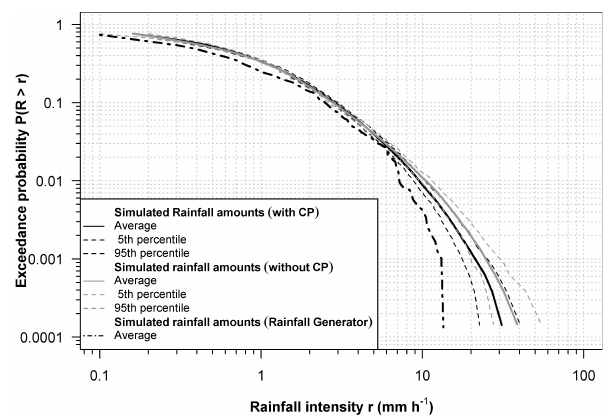
Fig. 11. Cumulative distribution functions of hourly rainfall amounts from synthetic time series as generated by the cascade models (with and without CP) and the rainfall generator for the period 1979–1989. No observations of hourly rainfall amounts are available for this